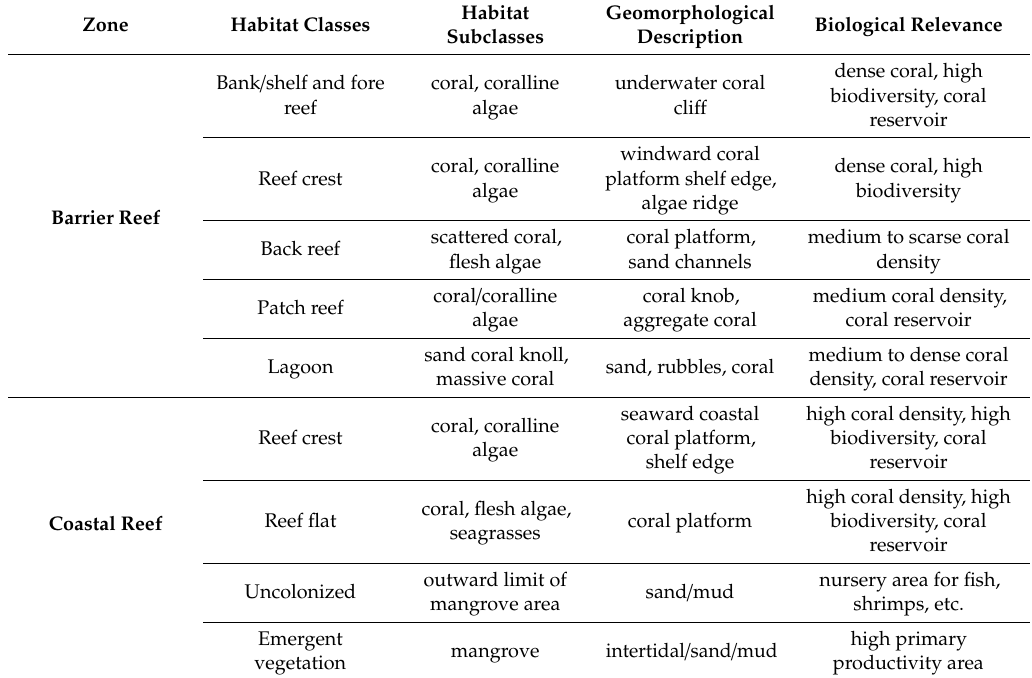
Table 1. Geomorphological description and biological importance of the main classes / subclasses used for the Palau habitat mapping with Sentinel-2